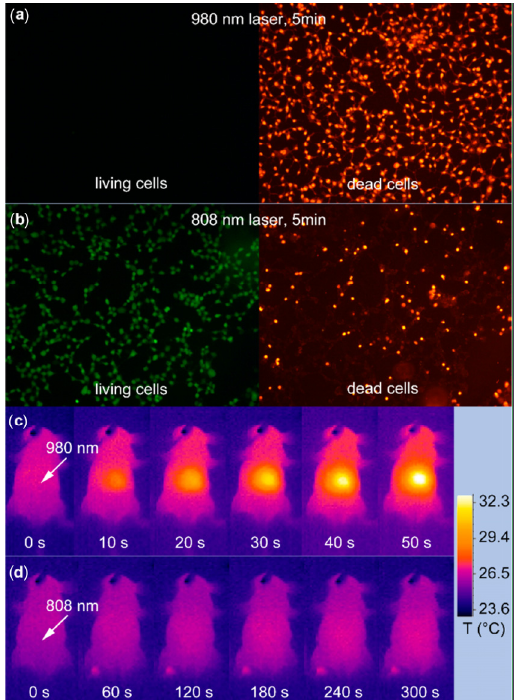
Figure 13. In vitro and in vivo heating effect induced by laser irradiation. ( a , b ) HEK (Human Embryonic Kidney) 293T cells after 5 min irradiation of 980 nm ( a ) and a 808 nm laser ( b ). Living cells and dead cells were stained with calcein AM (Acetomethoxy) and propidium iodide, respectively. ( c , d ) Infrared thermal image of a nude mouse during continuous ( c ) 980 nm laser irradiation for 50 s and ( d ) 808 nm laser irradiation for 300 s. Irradiation spots are denoted with the white arrows. Adapted with permission from reference [113]. Copyright: American Chemical Society,